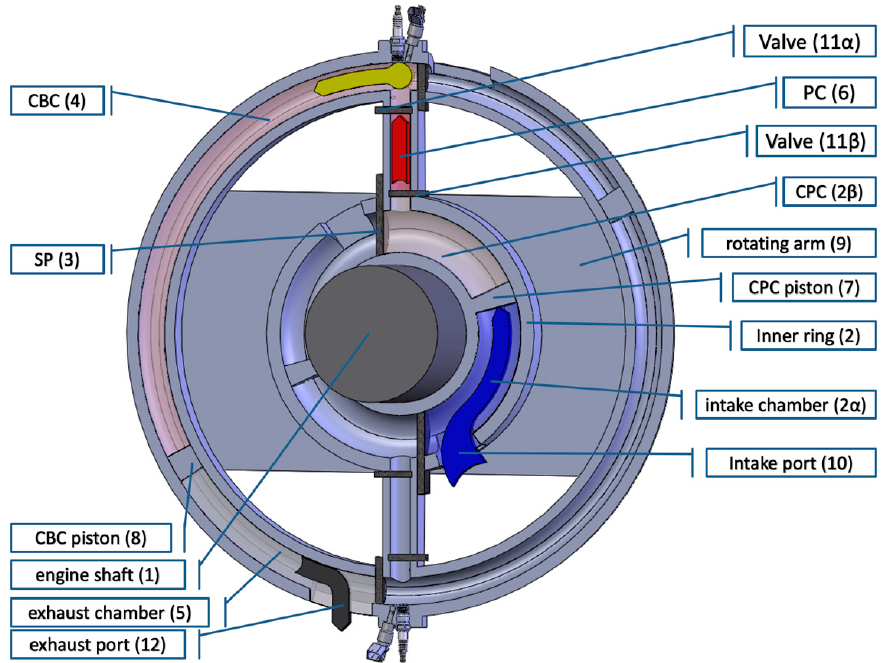
Figure 1. Savvakis Rotary Motor (SARM) engine layout.